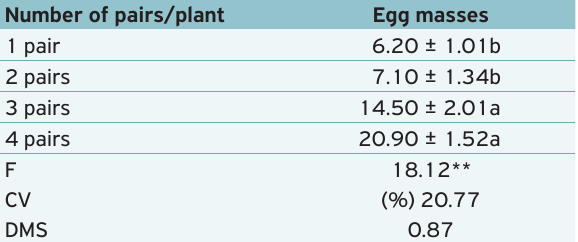
Table 1. Number (mean ± standard deviation) of Spodoptera frugiperda egg masses/cotton plant, BRS Ita 90 variety, according to adult